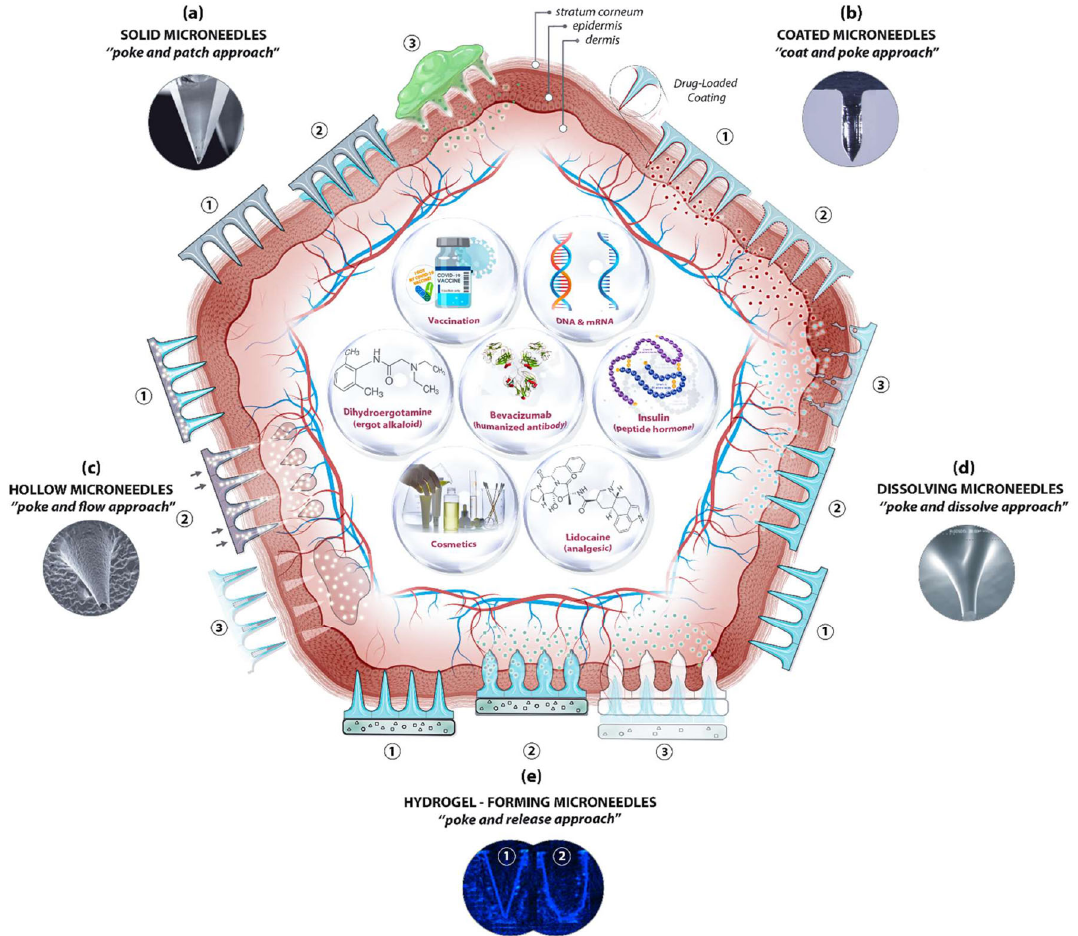
Figure 2. Schematic diagram of drug delivery method based on microneedles (MN): ( a ) solid MN; ( b ) coated MN; ( c ) hollow MN; ( d ) dissolving MN; ( e ) swelling MN. The step-by-step process for each delivery method is numbered from 1 to 3. It shows representative microscopic images of MN types and examples of deliverable substances, such as insulin, vaccines, DNA and RNA. Image used with permission of